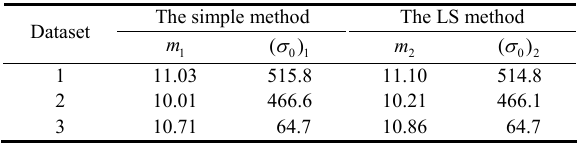
Table 1 Estimated Weibull parameters for the three examined datasets